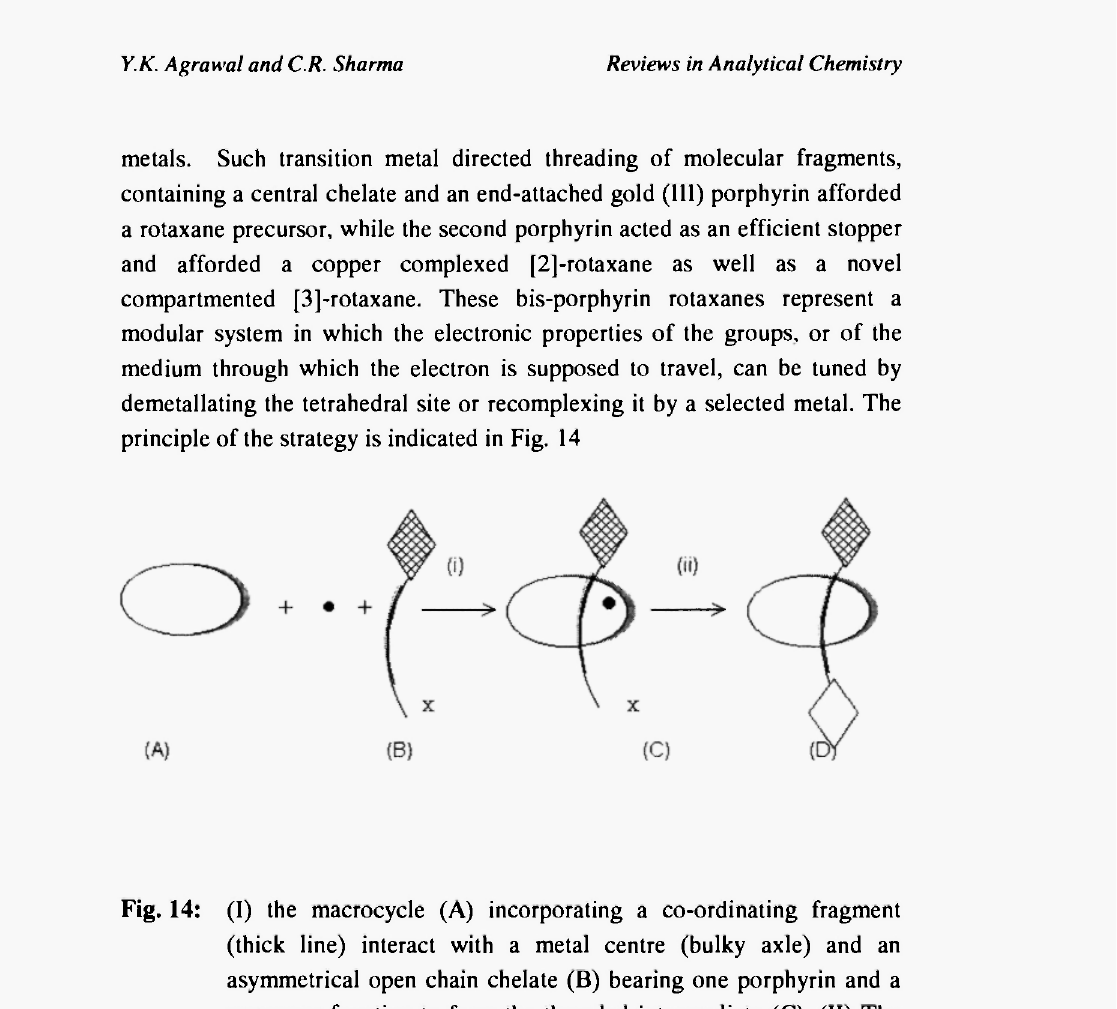
Fig. 14: (I) the macrocycle (A) incorporating a co-ordinating fragment (thick line) interact with a metal centre (bulky axle) and an asymmetrical open chain chelate (B) bearing one porphyrin and a precursor function to form the threaded intermediate (C). (II) The second porphyrin ring is then constructed, affording the transition metal complex-rotaxane